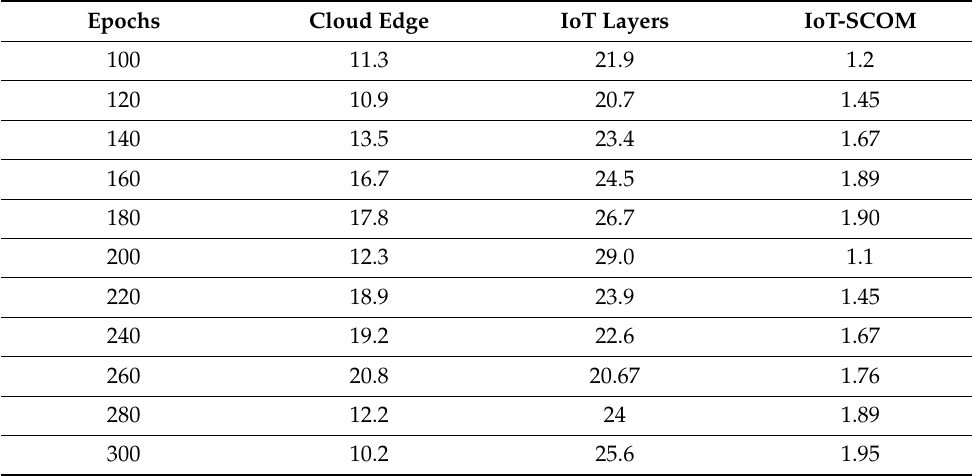
Table 2. The mean response period (sec) of the proposed